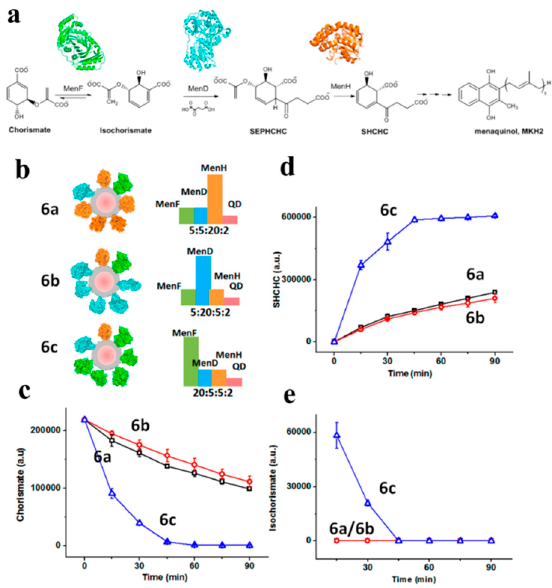
Figure 9. Enhancement of a three-enzyme cascade with QDs. ( a ) Cascade enzymes in the menaquinone synthetic pathway catalyze sequential conversion of chorismate. The structures of MenF, MenD, and MenH were drawn based on their crystal structures (PDB IDs 2EUA, 2JLC, and 2XMZ) and color coded, respectively. Composition of the enzymes in the assemblies drastically affected the catalytic efficacy and intermediate flow. ( b ) Schematic illustration of three multienzyme − QD assemblies with excess MenH (6a), MenD (6b), and MenF (6c), respectively. ( c ) Product (SHCHC) generation catalyzed by the three assemblies. ( d ) Substrate (chorismate) consumption catalyzed by the three assemblies. ( e ) Intermediate (isochorismate) accumulation catalyzed by the three assemblies. The total amounts of the enzymes and QDs, volumes of the reaction solutions, and the initial concentrations of chorismate were all the same in 6a, 6b, and 6c. Reprinted